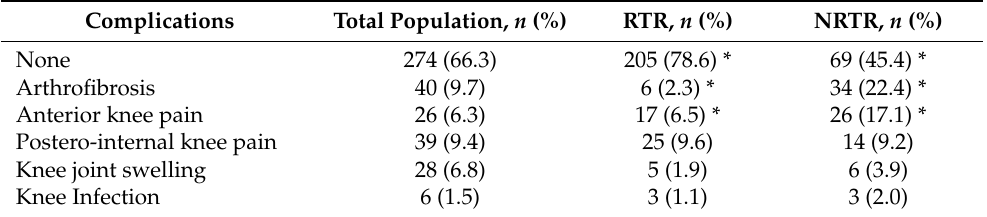
Table 3. Proportions of patients with complications amongst the return-to-running and the no-return- to-running groups.